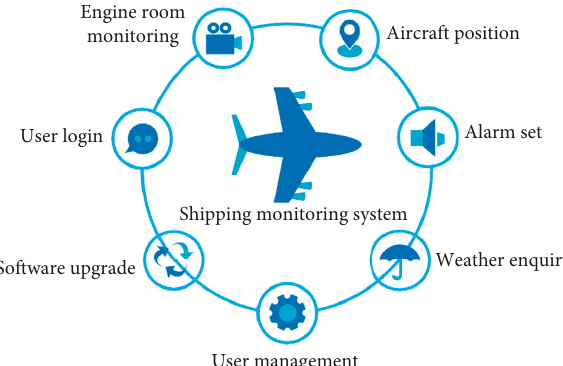
Figure 1: Flowchart of ship monitoring